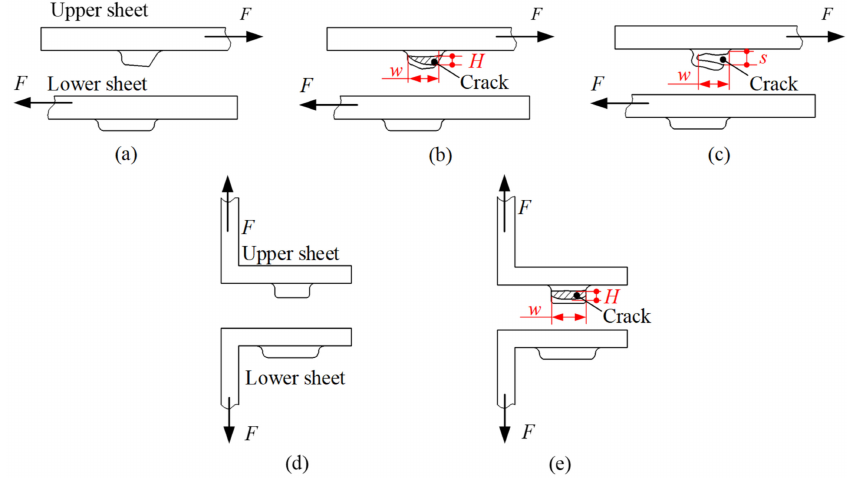
Figure 7. Schematic diagram of the failure forms of the upper sheet in shear and peel tests. ( a ) Unbuttoning, ( b ) tearing, ( c ) shearing, ( d ) unbuttoning and ( e )